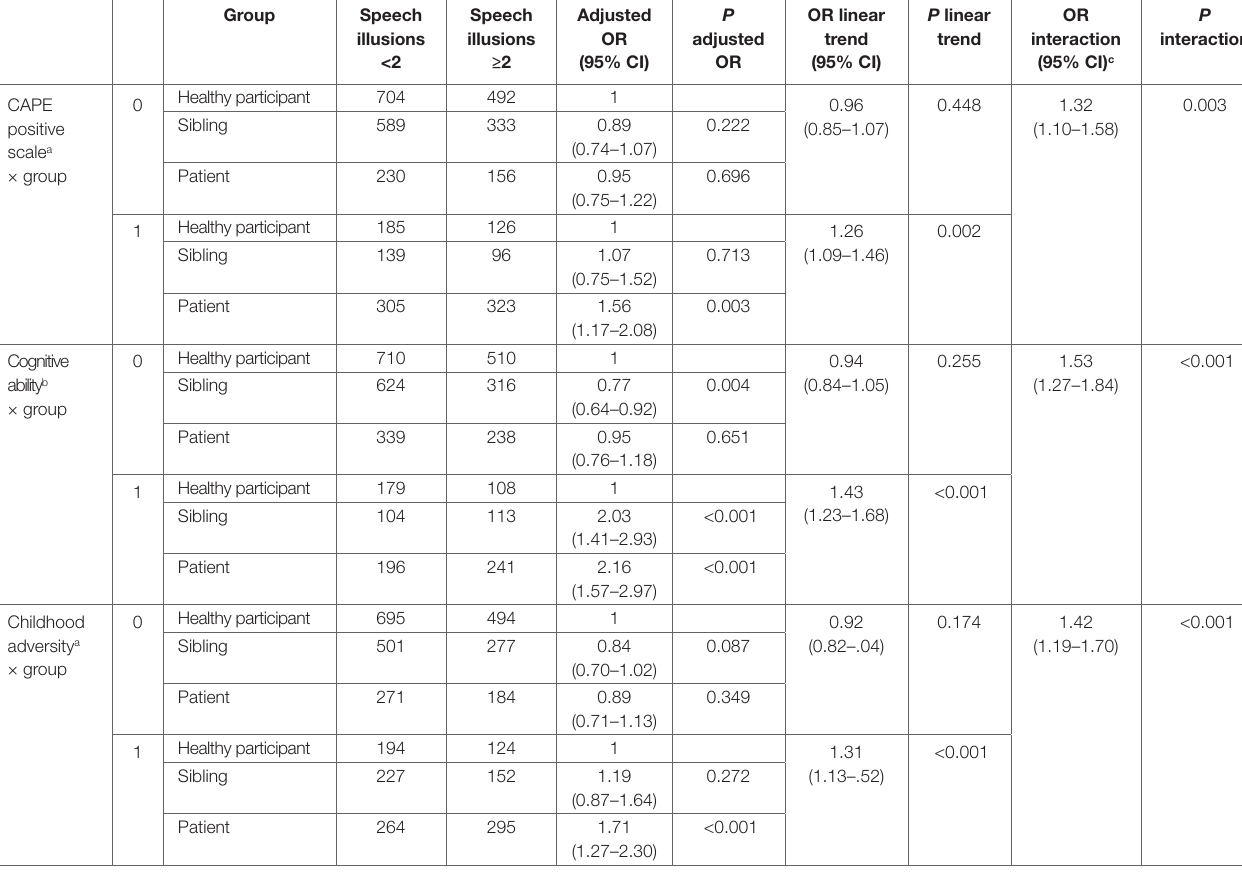
TABLE 2 | Interaction between group and CAPE positive scale, cognitive ability, or childhood adversity in any white noise speech illusion.